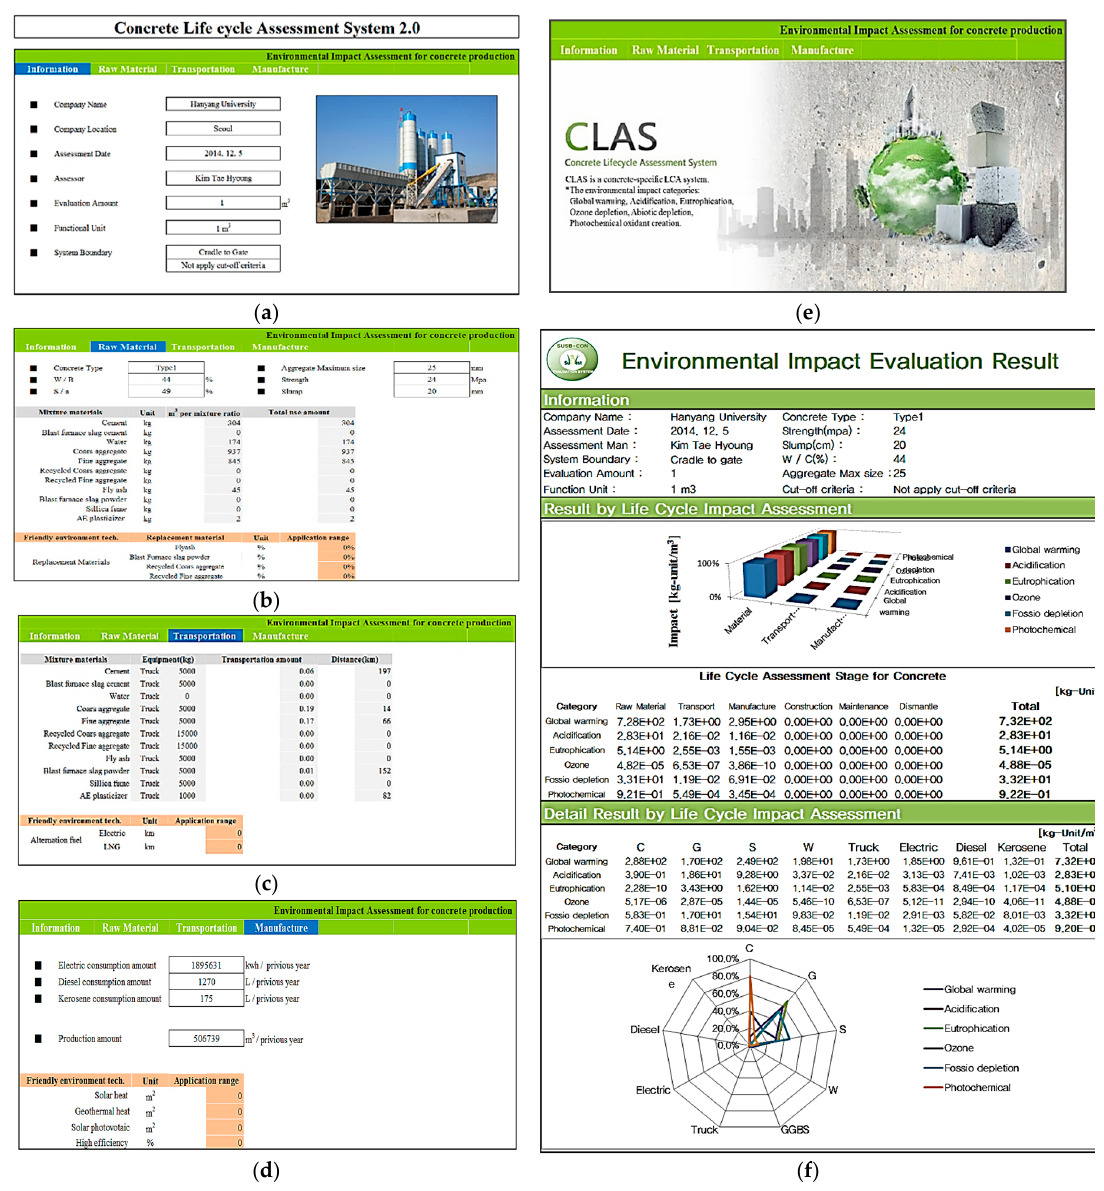
Figure 3. Concrete Life cycle Assessment System: ( a ) basis information sheet; ( b ) raw material stage sheet; ( c ) transportation stage sheet; ( d ) manufacture stage sheet; ( e ) main screen; and ( f ) result screen.